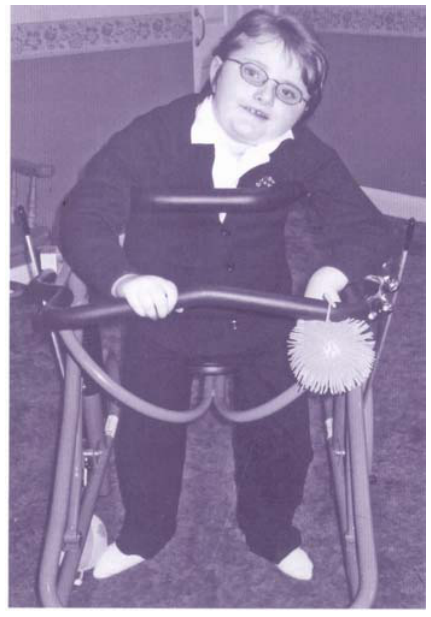
PICTURE 23 . Use of rollator with trunk support by a child with